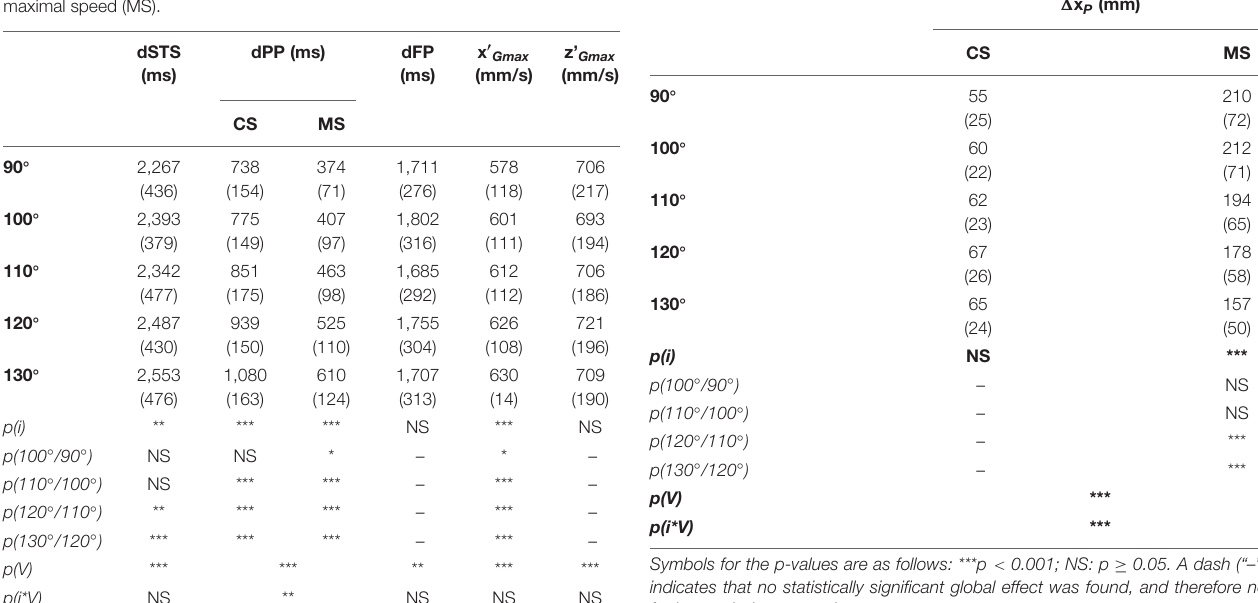
TABLE 5 | Mean (SD) total durations of the STS (dSTS), duration of the postural phase (dPP), maximal CoG anteroposterior velocity (x (cid:48) Gmax ), for the 5 inclination conditions and for the 2 speed conditions: comfortable speed (CS) and maximal speed (MS).